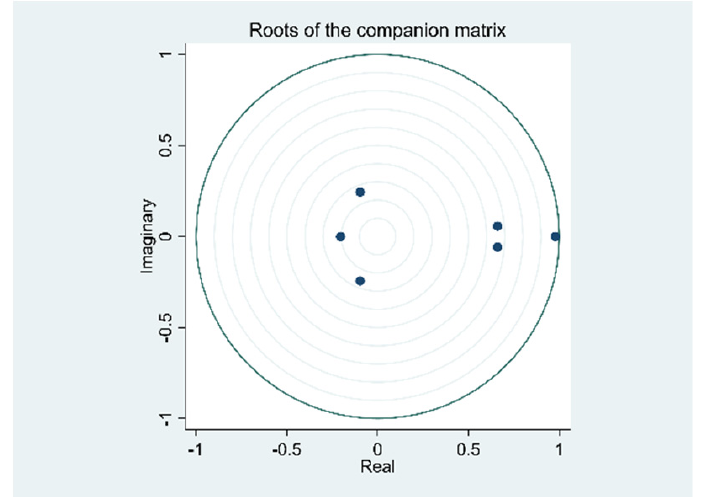
Figure 9. Balance test of data concerning the coal consumption rate of fossil power plants.